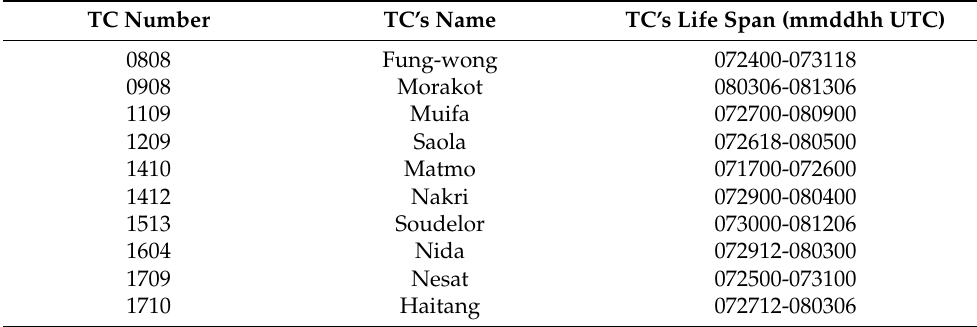
Table 1. Basic information about the TCs on the PRD regional heatwave